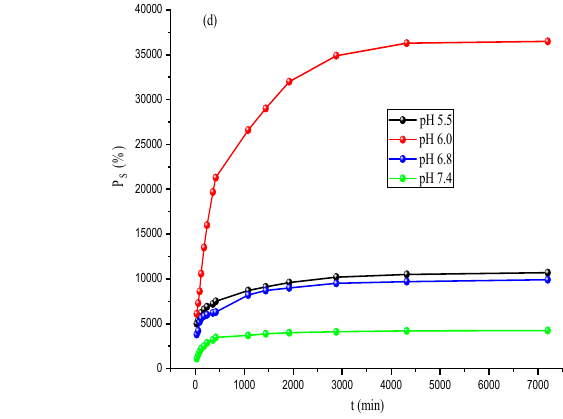
Figure 6. Swelling ratio (S r ) of the MOGN at 37 °C for pHs (2.4–5.0) from 5–1400 min ( a ) and pHs (5.5–7.4) from 5–7200 min ( b ); % swelling (P s ) of MOGN at 37 °C for pH (2.4–5.0) from 5–1440 min ( c ) and pHs (5.5–7.4) from 5–7200 min ( d ).